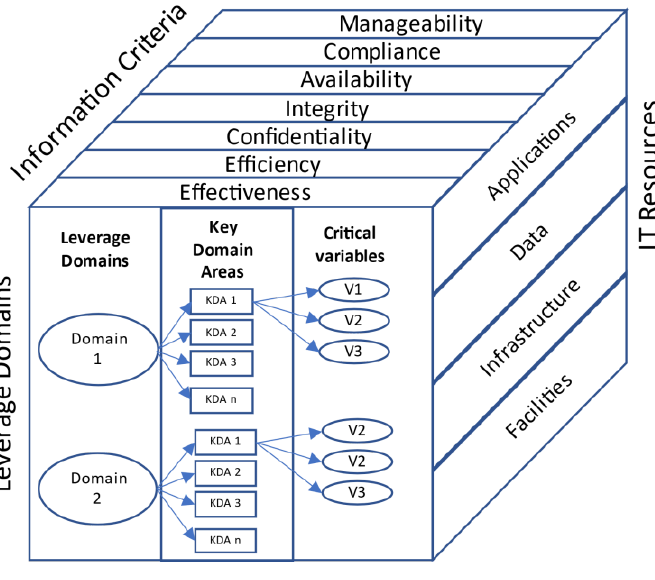
Figure 4: Three dimensions of eGovernment Maturity Model by Iribarren et al. (2008, p.